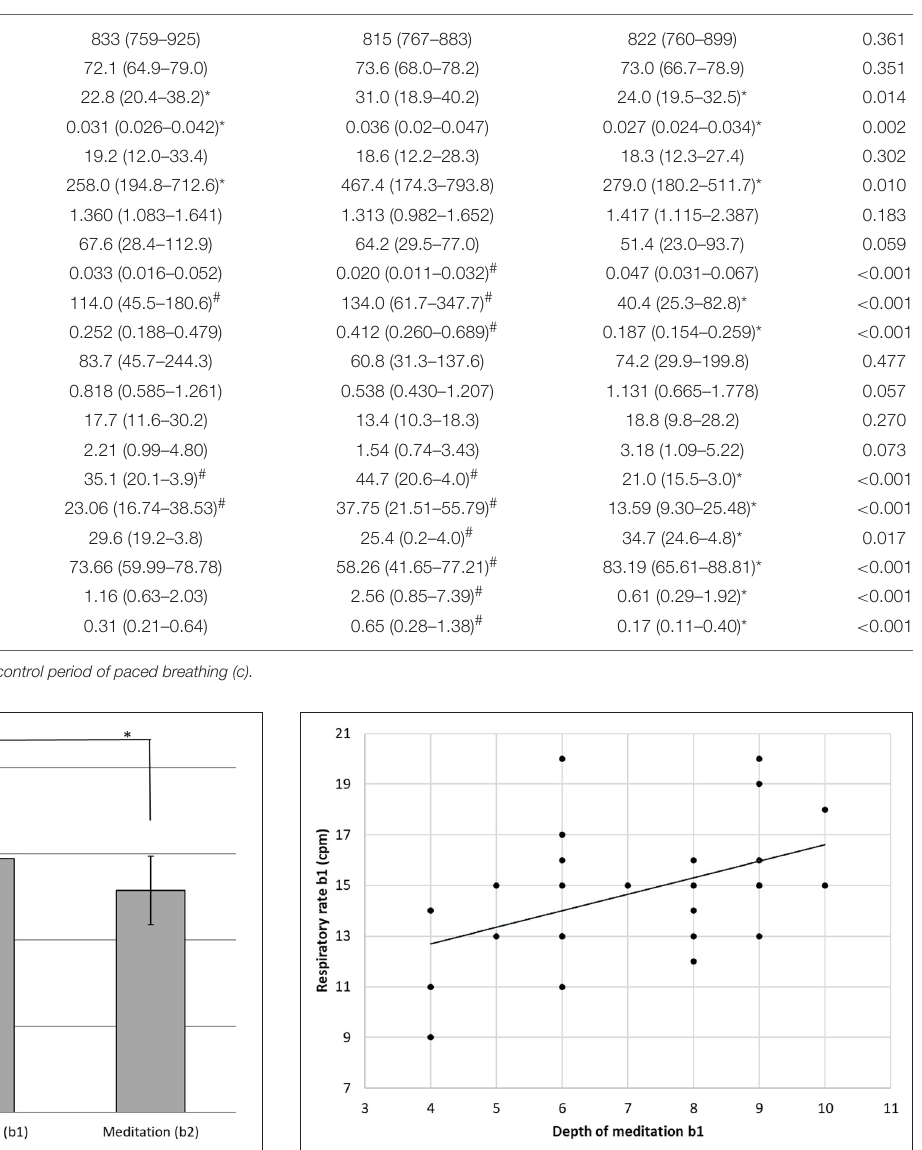
TABLE 1 | Comparison of HRV and rHRV measures among at rest (a), during deep medication (b1), at the end of medication (b2), and during the control period (c). At rest (a) Deep meditation (b1)